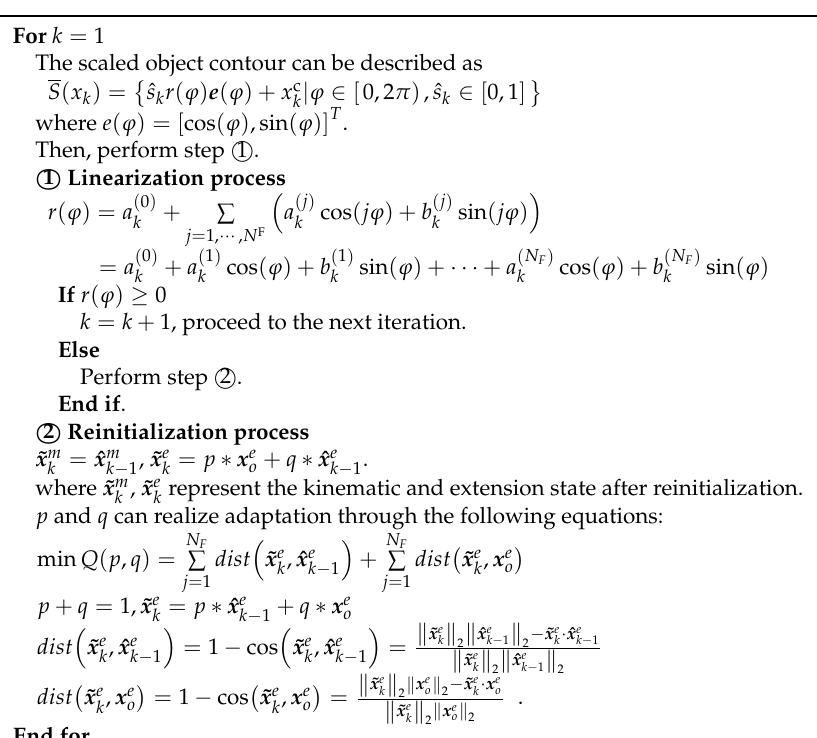
Table 3. Pseudo codes of the proposed Method.